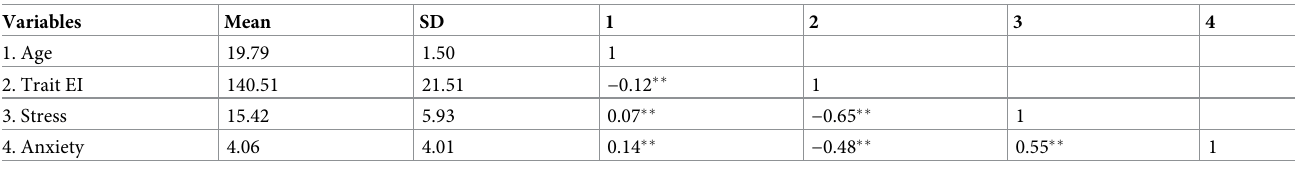
Table 2. Means, standard deviations (SD) and correlations of continuous variables.